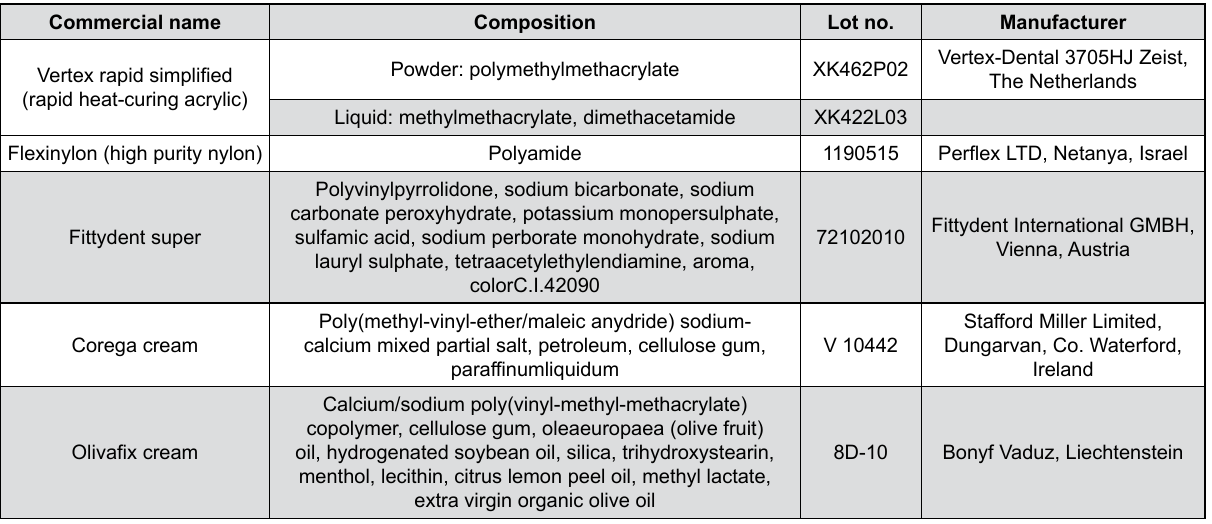
Figure 1- Commercial name, composition and manufacturer of the materials used in the